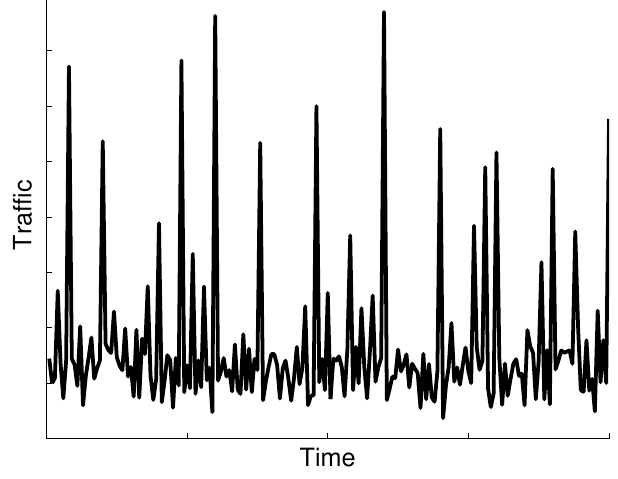
Figure 2. Example of M2M traffic peaks.